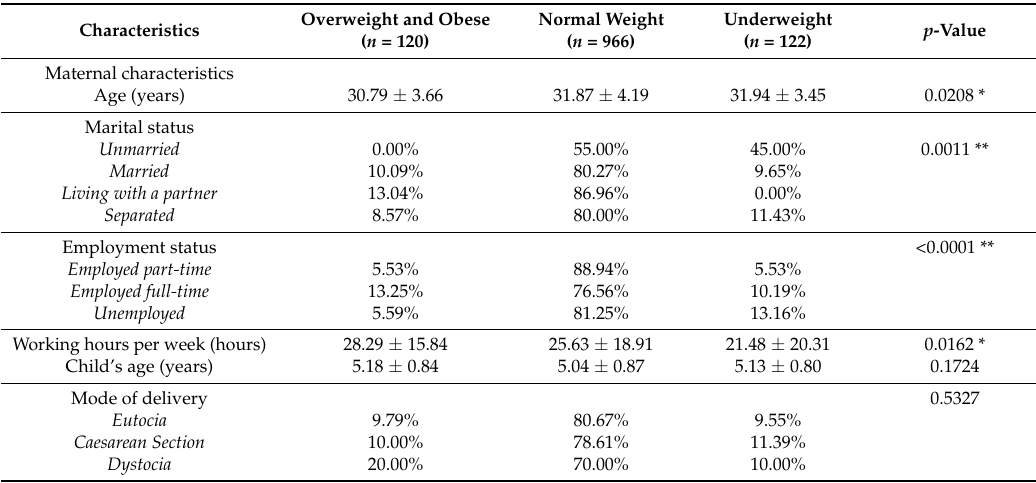
Table 1. Descriptive statistics for Participant by children’s weight status (Mean ±